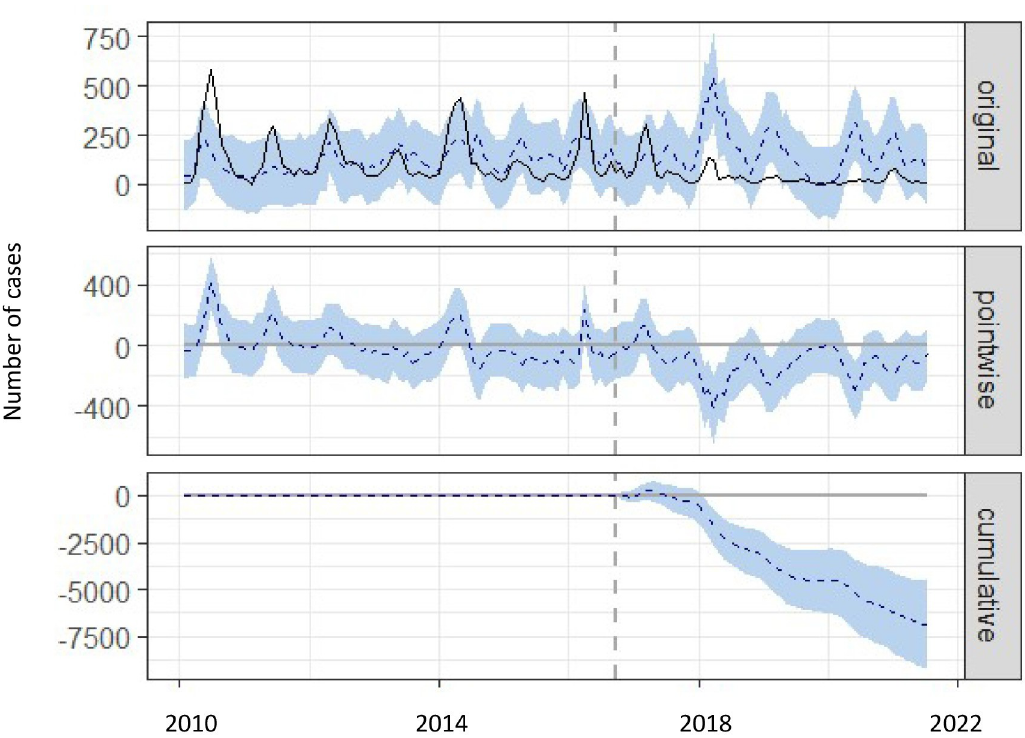
Fig 5. The monthly counts of HFMD during 2010–2021 and the comparison with expected infection among 2017–2021 in Zhejiang Province, China. The first panel shows the data and a counterfactual prediction for the posttreatment period. The second panel shows the difference between observed data and counterfactual predictions. The third panel sums the pointwise contributions from the second panel, resulting in a plot of the cumulative effect of the